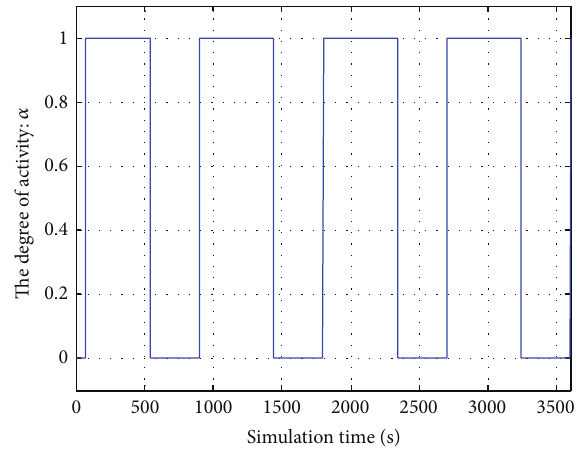
Figure 1: The varying activity 𝛼 in